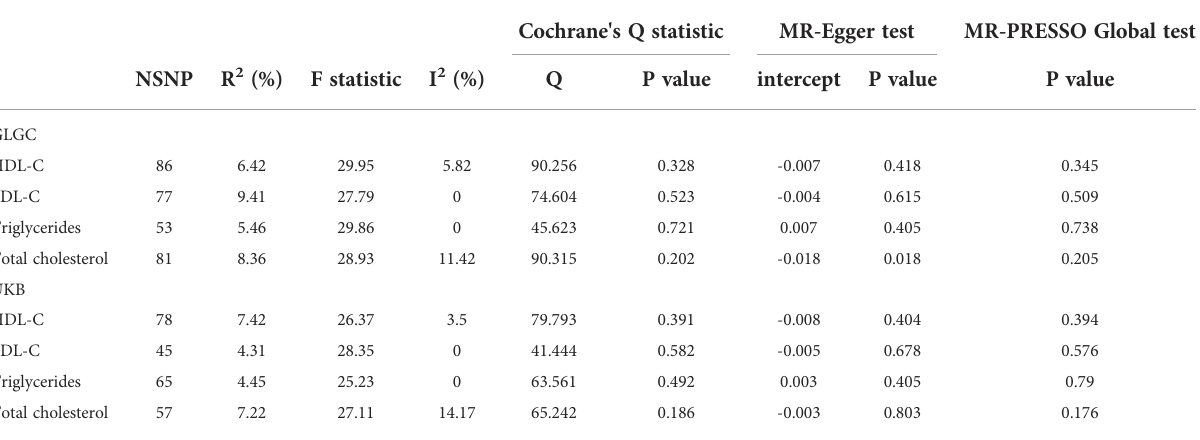
TABLE 1 Mendelian randomization results of lipid traits on